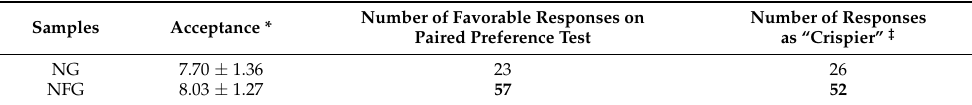
Table 2. Results from sensory evaluation of nachos covered with guacamole (NG) or with film (film #3, produced by continuous casting) and guacamole